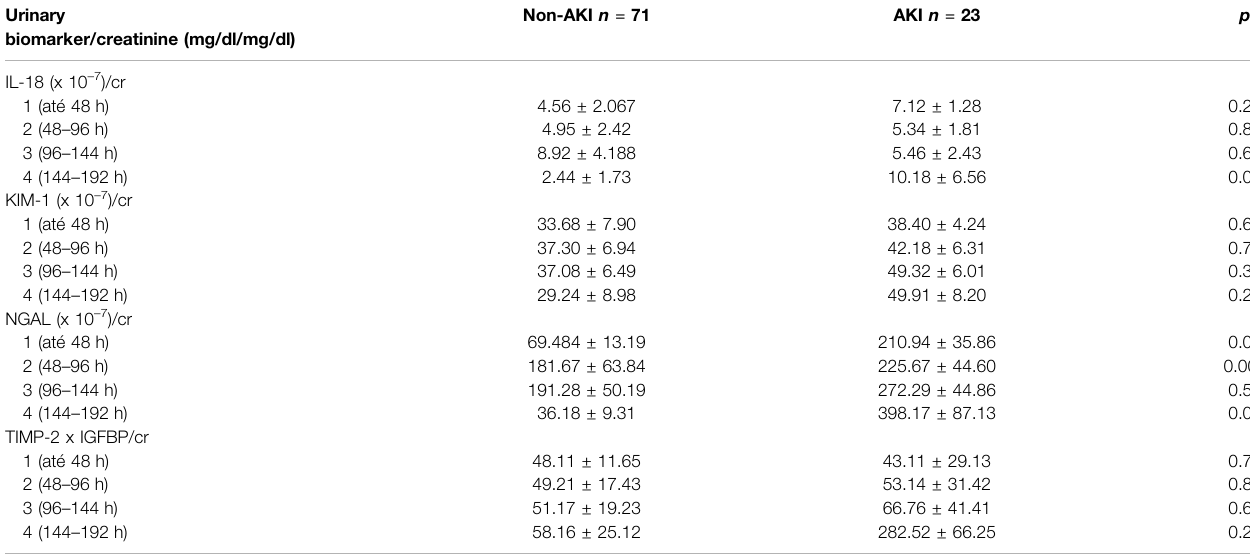
IL-18,interleukin18;KIM-1,kidneyinjurymolecule-1;NGAL,neutrophilgelatinase-associatedlipocalin;TIMP-2,tissueinhibitorofmetalloproteinases2;IGFBP-7,insulin-likegrowthfactor binding protein 7